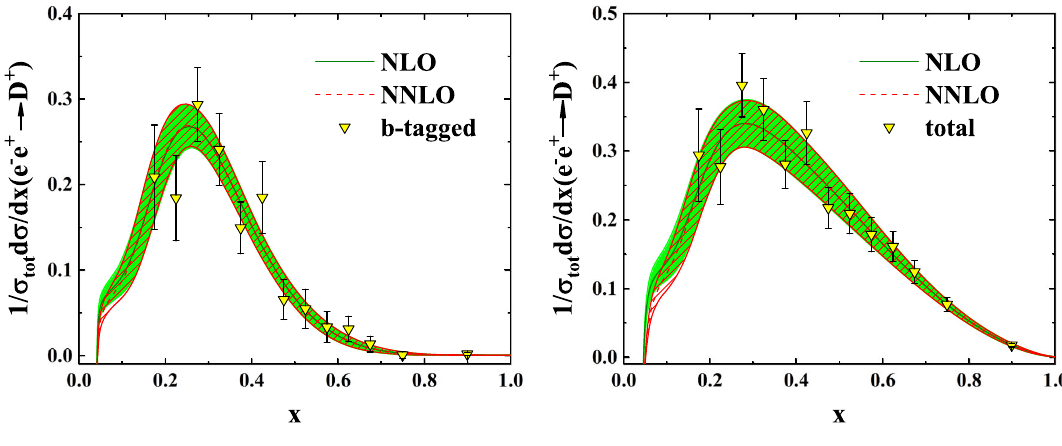
Fig. 4 Same as Fig. 3 but for the D + meson